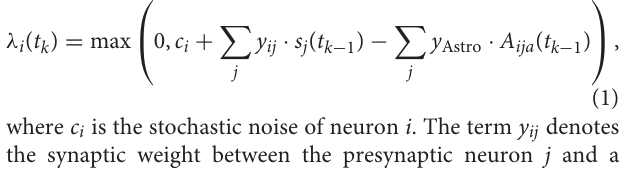
(2) the effect of astrocytic ATP on the postsynaptic activity, (3) the release of glutamate from the presynapse and the uptake of glutamate by the astrocyte, and (4) the excitatory and/or inhibitory synaptic